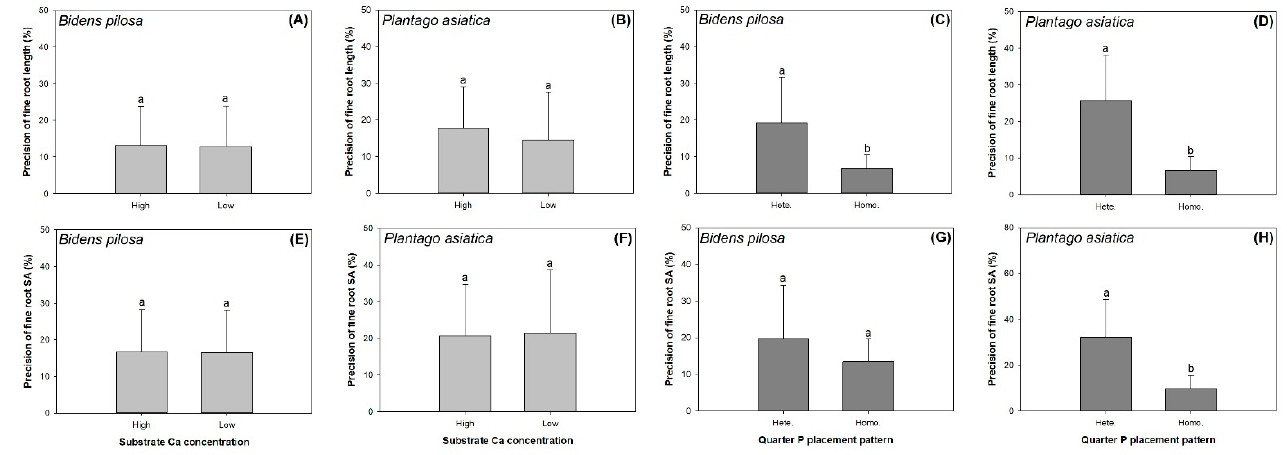
Figure 5. Fine root foraging precision gauged as length ( A ‒ D ) and surface area (SA) ( E ‒ H ) in Bidens pilosa and Plantago asiatica plants subjected to phosphorus (P) input as heterogeneous (Hete.) and homogeneous patterns (Homo.) at high calcium (Ca) (2 g kg − 1 ) and low Ca levels (0.63 g kg − 1 ). Error bars stand for standard errors. Same letters in a cell of figure indicate the failure to find significant difference by Duncan’s new multiple range test at the p < 0.05 level.